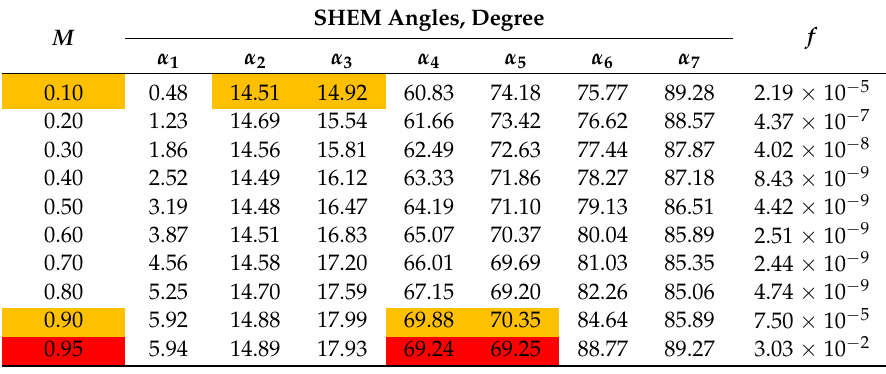
Table 5. SHEM Angles Found by PSO Algorithm for N = 7 and Case II. (Yellow M: Not recommended, Red M: Impractical). SHEM Angles, Degree M